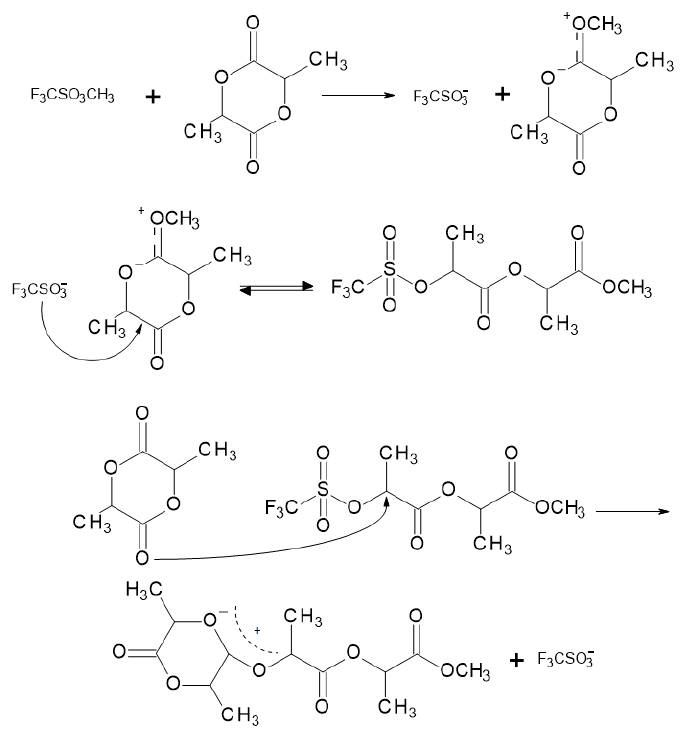
Figure 10. Cationic ring-opening polymerization mechanism for PLA [21].